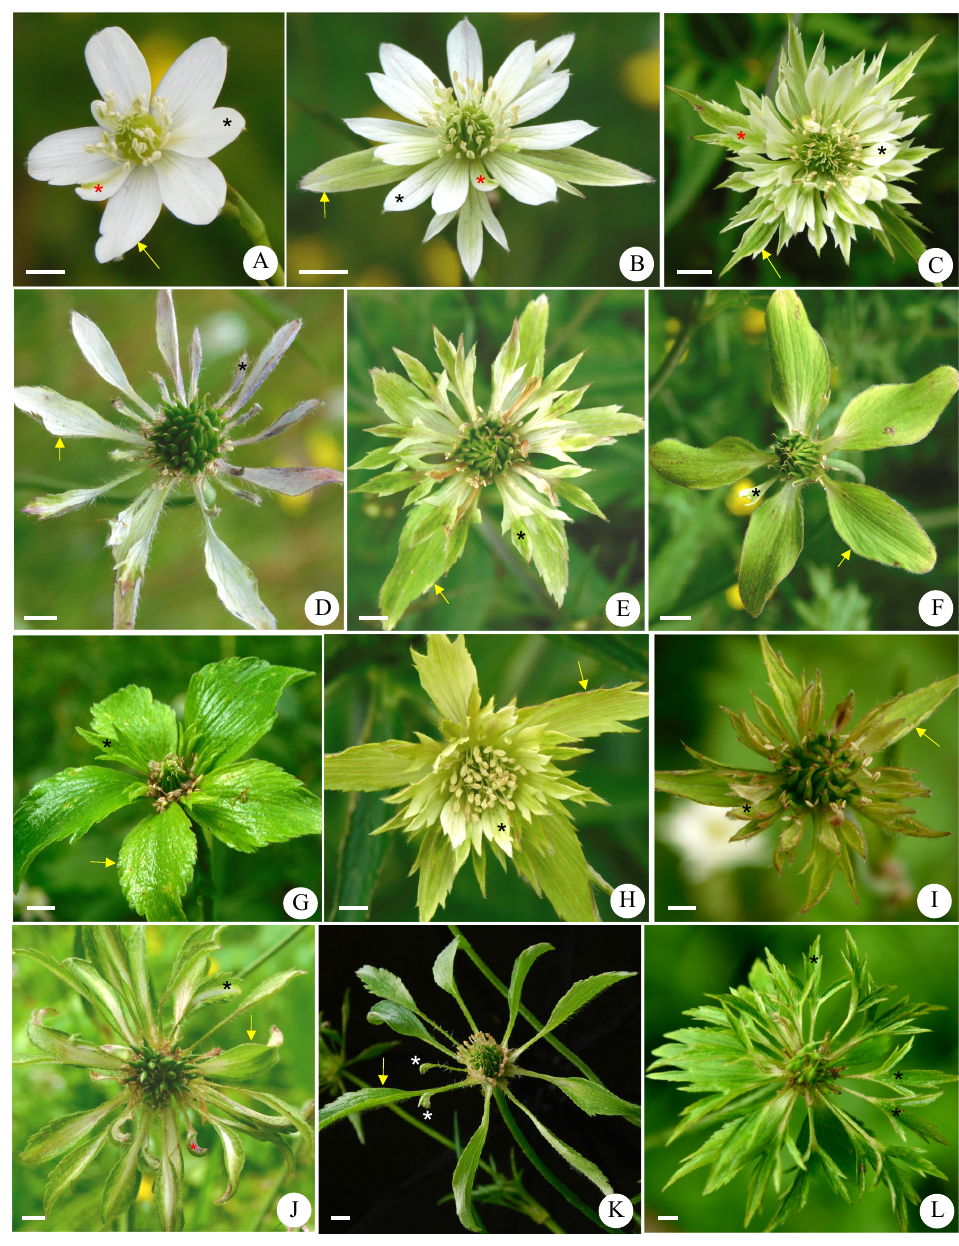
Figure 2. Mature and abnormal flowers of Anemone barbulata . ( A ) Several stamens metamorphosed into the white sepaloid structures (black star) with some containing the pollen sacs to generate pollen grains formed on one side (red star). ( B ) A part of the androecium metamorphosed into white sepaloid structures (black star) with some containing the pollen sacs to generate pollen grains formed on one side (red star). ( C ) Many stamens metamorphosed into white structures showing the entire edge (black star) or 3-lobed structures (red star). ( D ) Many stamens transformed into white structures with many of them containing long stalks (black star). ( E ) A typic whorl of stamens transformed into 3-lobed white or green structures with some of them containing short stalks. ( F ) Several sta- mens metamorphosed into green structures containing a residual anther (black star). ( G ) Several stamens transformed into 3-lobed green structures. ( H ) Many stamens transformed into 3-lobed light green or white structures. ( I ) Many concave abnormal stamens arranged in whorls. ( J ) Many stamens transformed into either entire or 2–3-lobed white structures with long stalks and green edges. ( K ) Several leaflike abnormal stamens containing the fist-shaped anthers (next to white stars) and a long stalk. ( L ) Many transformed stamens of 3-lobed leaflike structures. Metamorphic sepals are indicated by yellow arrows; metamorphic stamens are indicated by black stars. Scale bar = 0.4